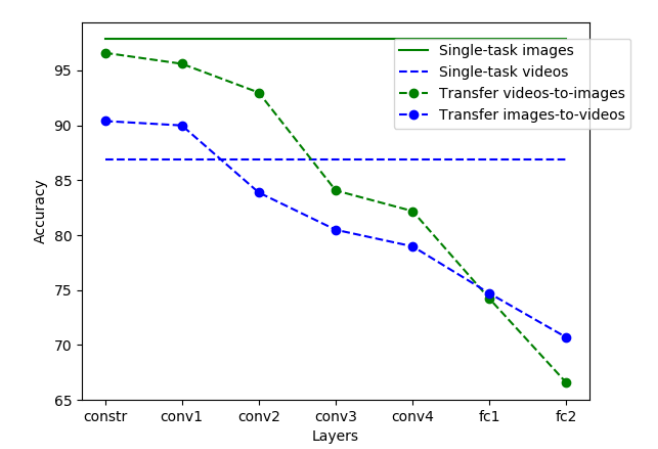
Figure 4. Comparison of baseline single-task learning, transfer-learning–based, and multitask- learning–based models accuracy on image (in green) and video (in blue)